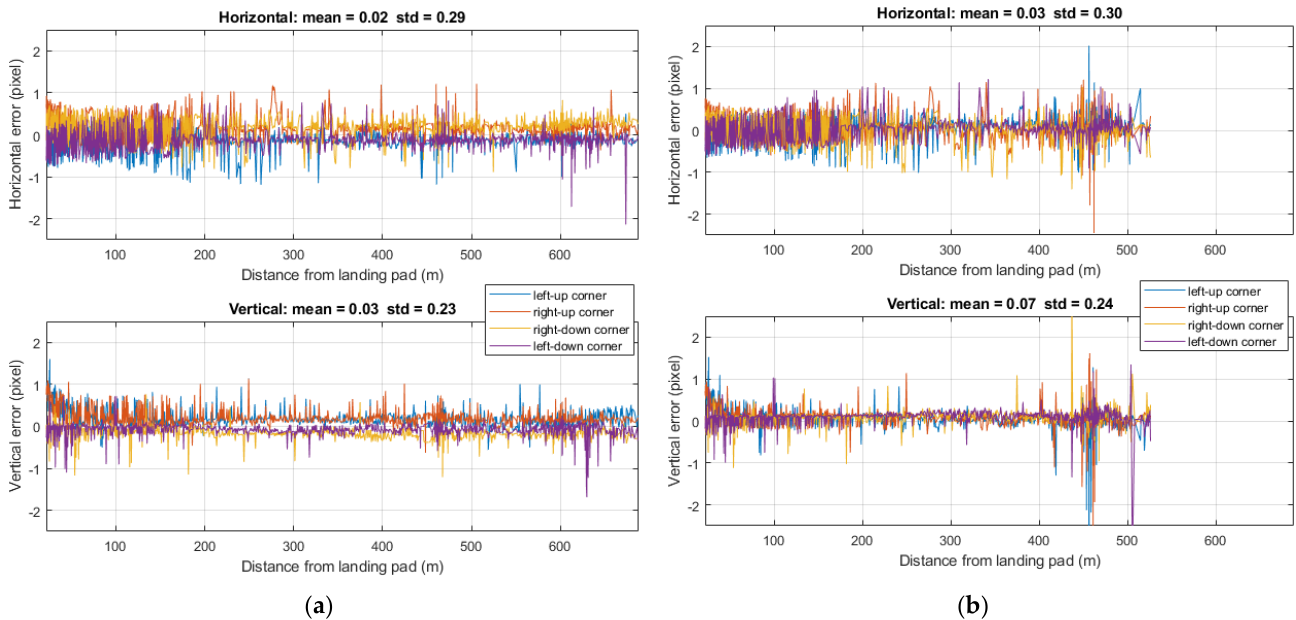
Figure 18. ( a ) Daylight: difference between the positions of the corners recognized by the image processing algorithm and their reprojections estimated through the true markers’ pose; ( b ) Low − visibility: difference between the positions of the corners recognized by the image processing algorithm and their reprojections estimated through the true markers’ pose. Corners’ legend is referred to the biggest marker of Figure 6a.